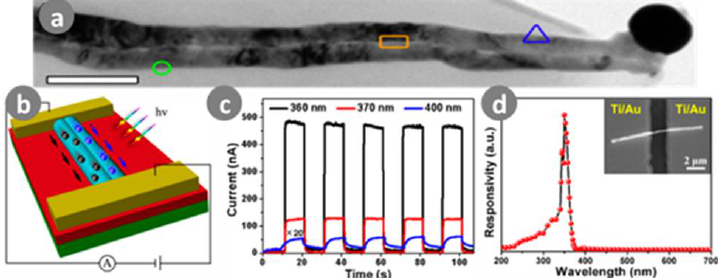
Figure 12. ( a ) TEM images of an single bicrystalline GaN nanowire with Ag catalyst terminated at the tip end; ( b ) Schematic diagram of a UV-A photodetector; ( c ) Under different irradiation wavelengths from 360 to 400 nm and a 5 V bias voltage and a power density of 6.41 W/cm 2 ; ( d ) Photoresponse